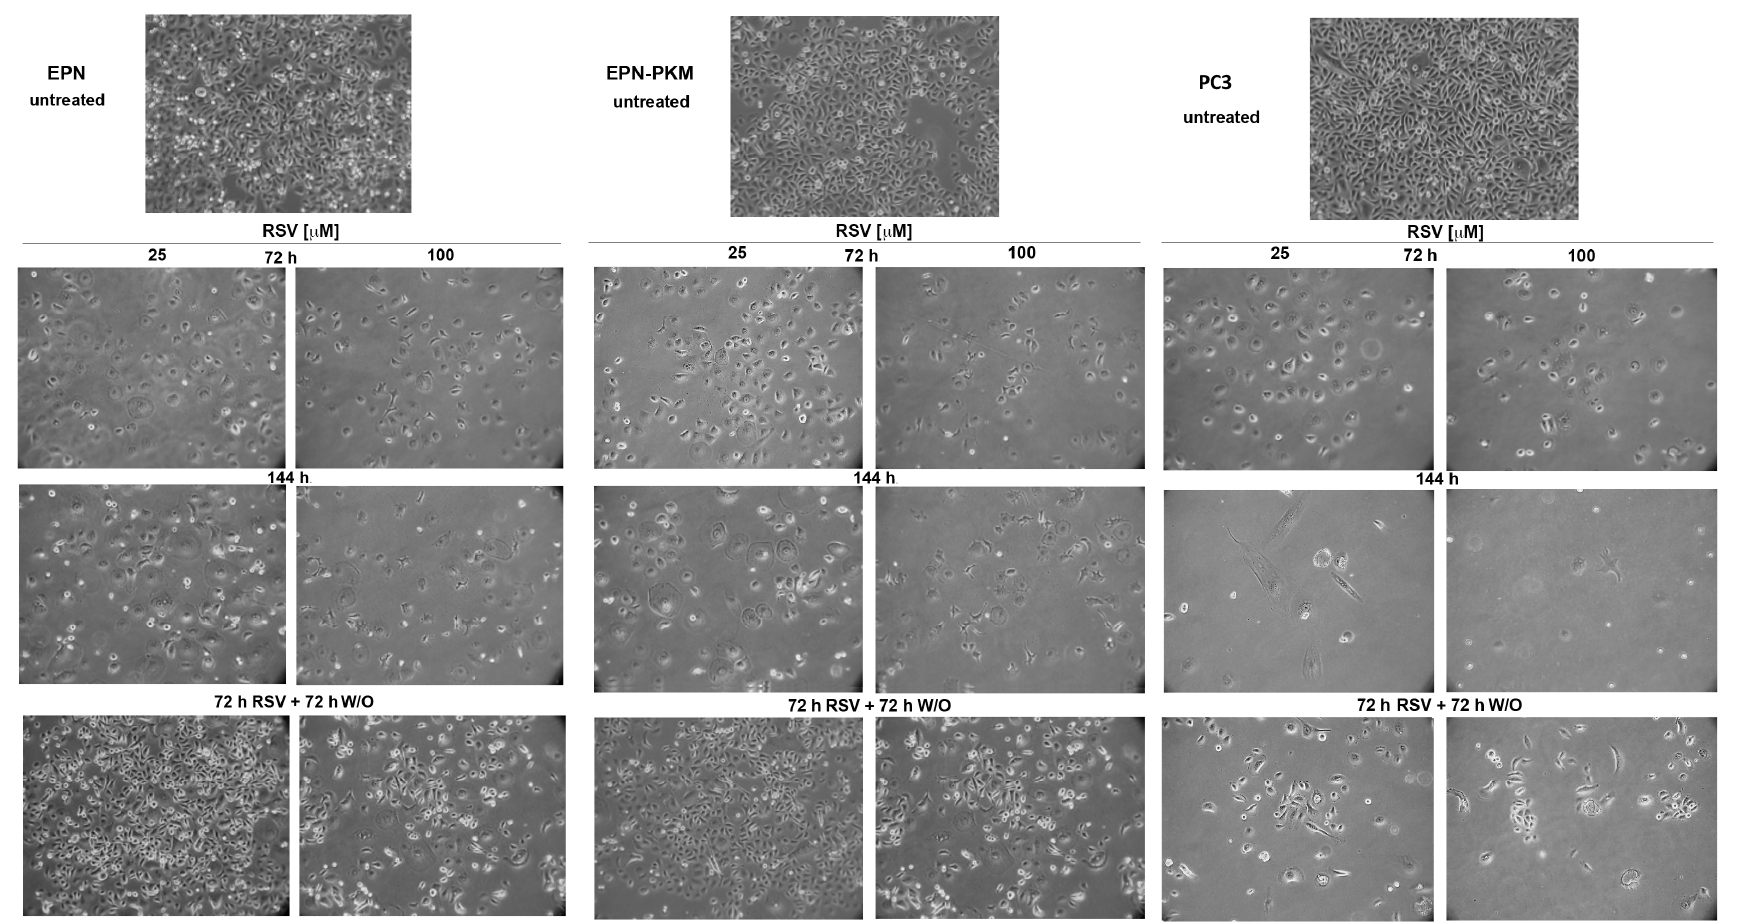
Figure 7. RSV effects on cellular morphology are reversible Microphotographs of representative fields of EPN, EPN-PKM and PC3 cells cultured in standard growing condition or in the presence of 25 and 100 µ M RSV for 72 or 144 h, or cultured for 72 h in the presence of 25 and 100 µ M RSV and for 72 h in its absence (72 h RSV + 72 h RSV W/O). Cells have been observed with Axiovert 25 and photographed with Canon GC5 (final magnification 40×).